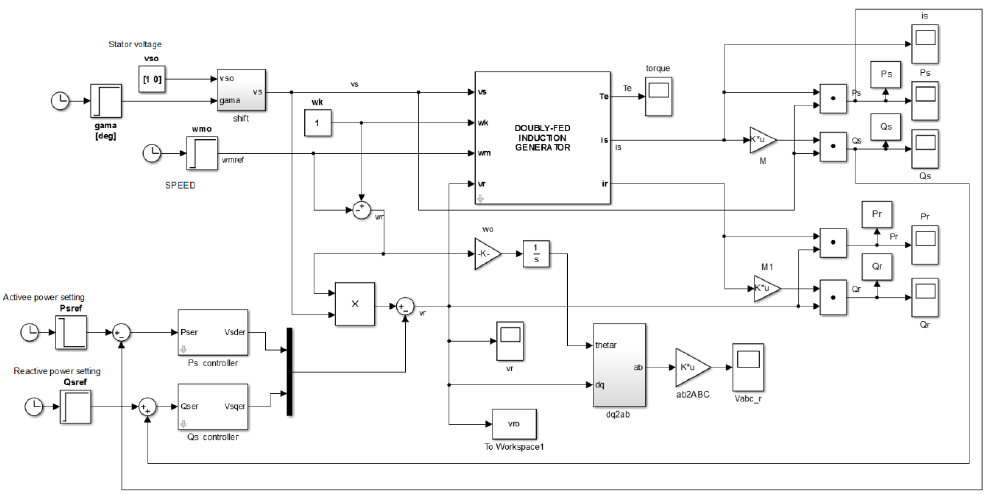
Figure 7. Simulated DFIG along with its control schemes .